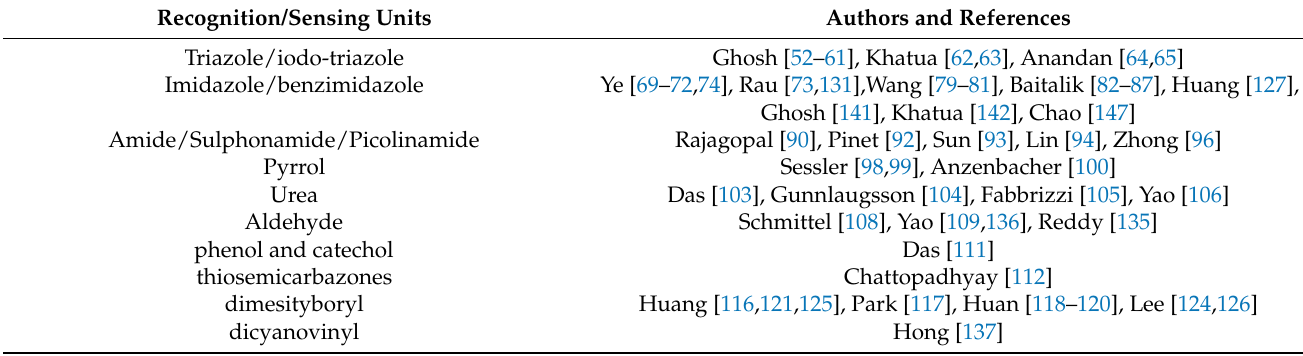
Table 1. Summary of different recognition/sensing unit-based sensors with accompanying